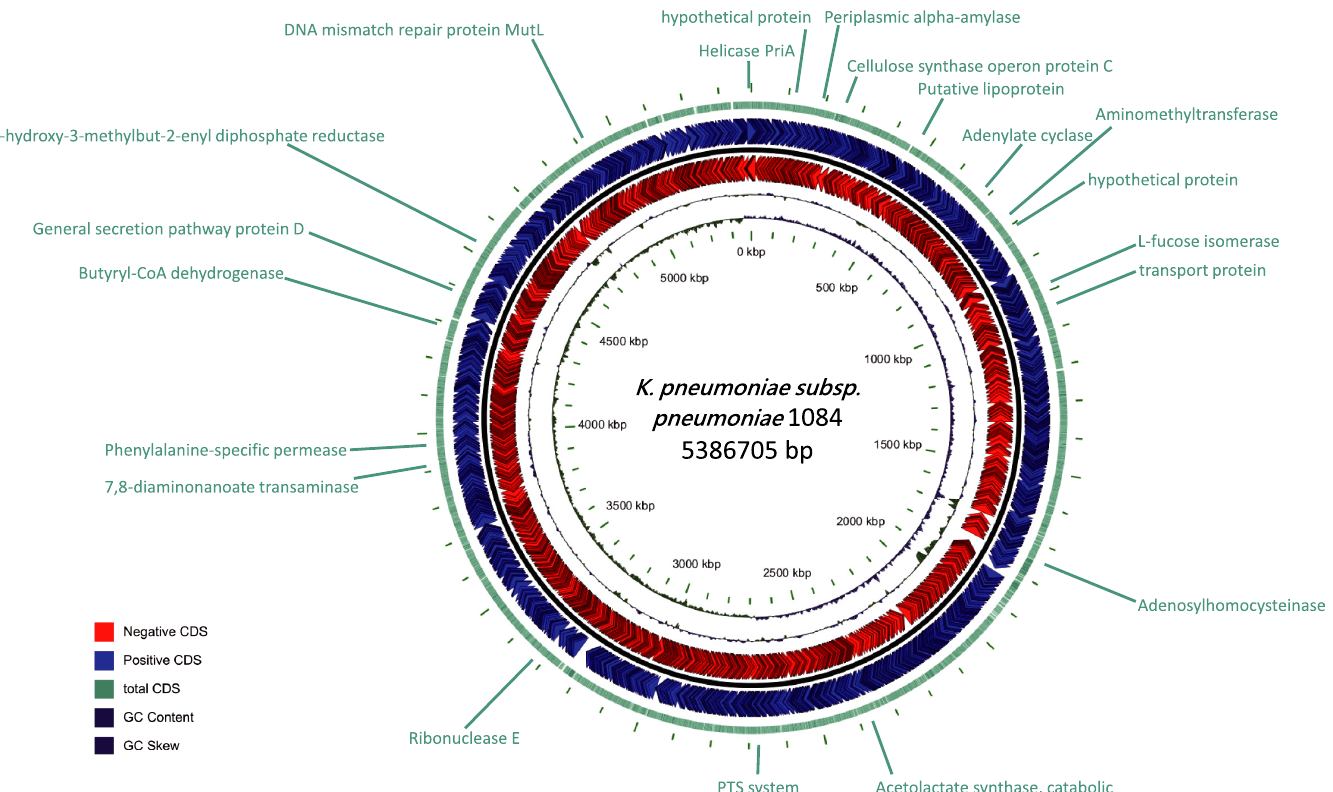
Fig 3. Circular map of the 2D reads in the context of a reference genome and corresponding annotation.